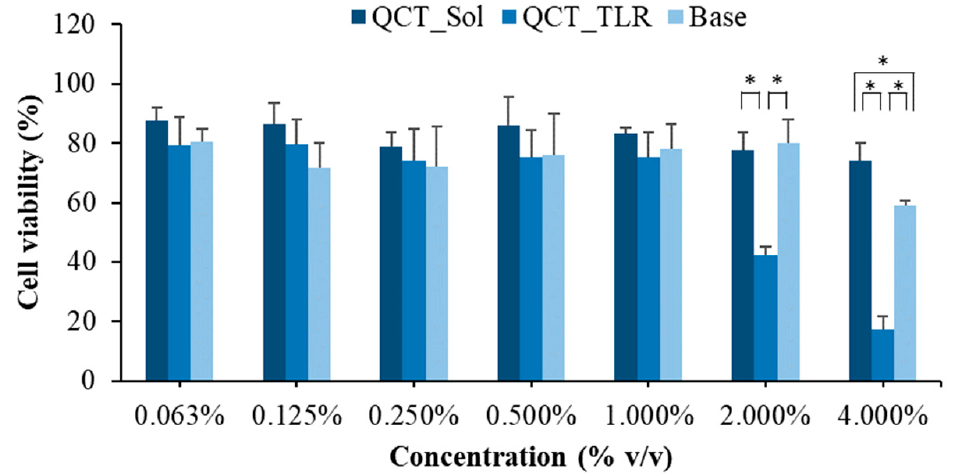
Figure 6. Percentage of cell viability after exposure to QCT_Sol (QCT solution in ethanol at the same concentration as those used in the SLNs), QCT_TLR, and base (10% w / w of CRH40 in water). * indicates significant difference ( p < 0.05).